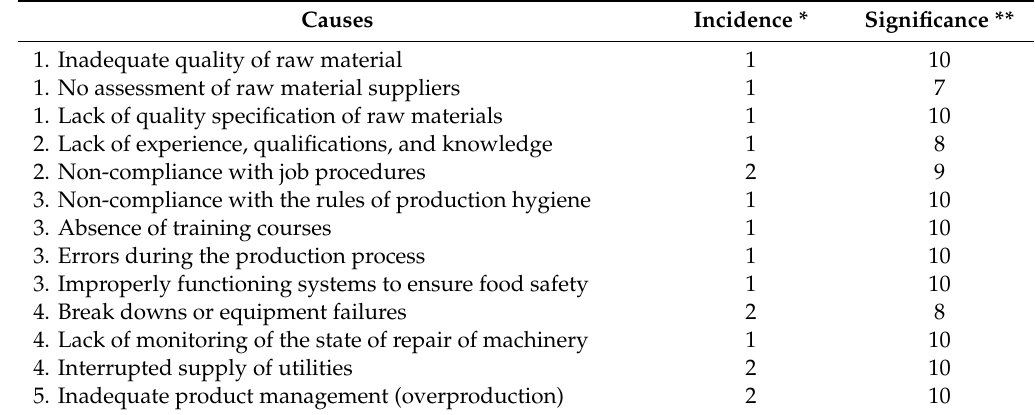
Table 5. The incidence of individual causes and their significance (average values in the five studied